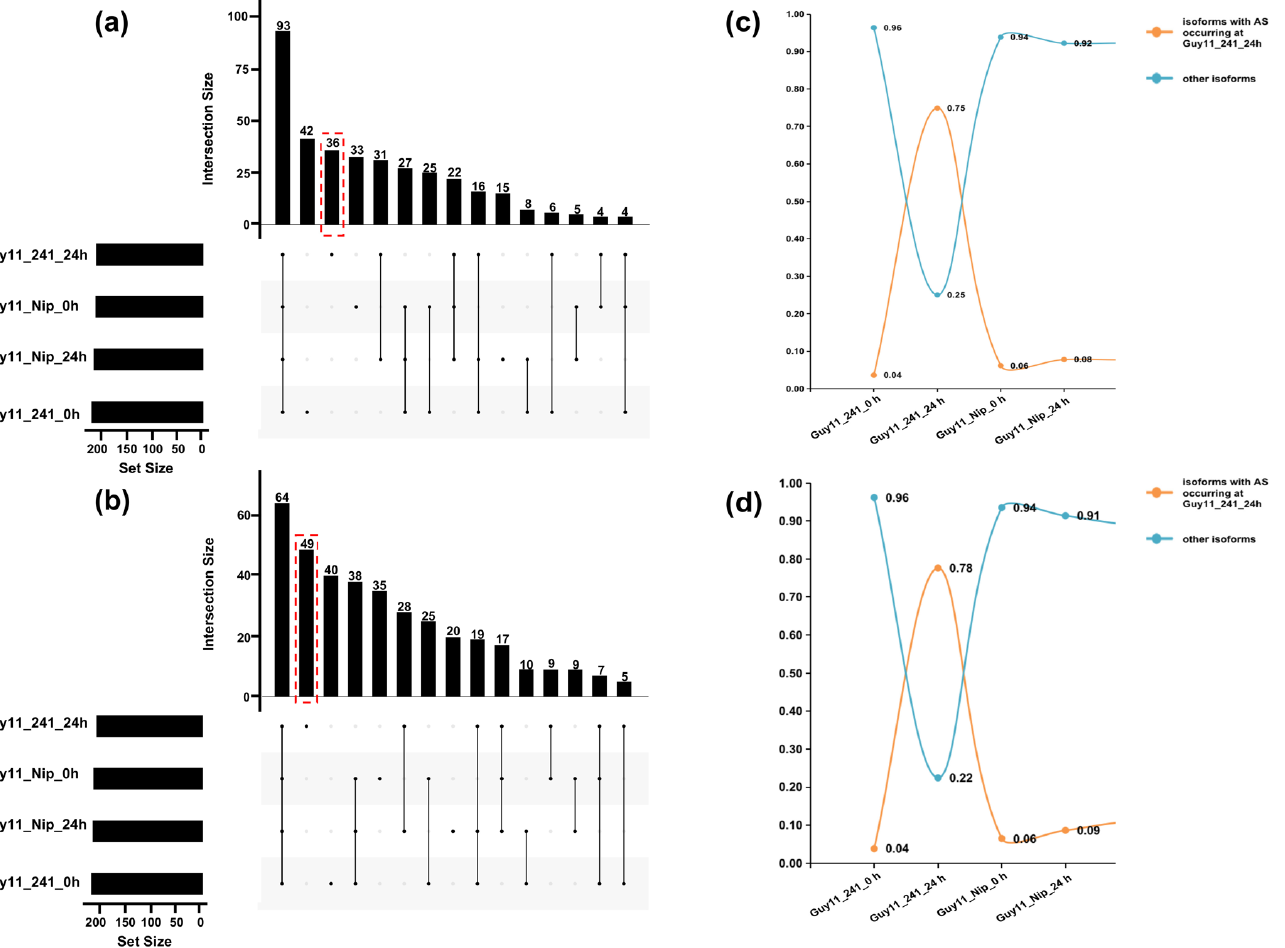
Figure 5. Distribution and average TUI values of primary transcripts/isoforms across all samples ( a , b ). Upset Venn plots showing overlapping primary annotated transcripts or novel isoforms at 24 hpi ( a ) and 48 hpi ( b ) in #241 and Nip. Red dashed box encloses infection-specific primary transcripts/isoforms in #241. ( c , d ) Average transcript usage index values for #241-specific primary annotated transcripts or novel isoforms at 24 hpi ( c ) and 48 hpi ( d ).